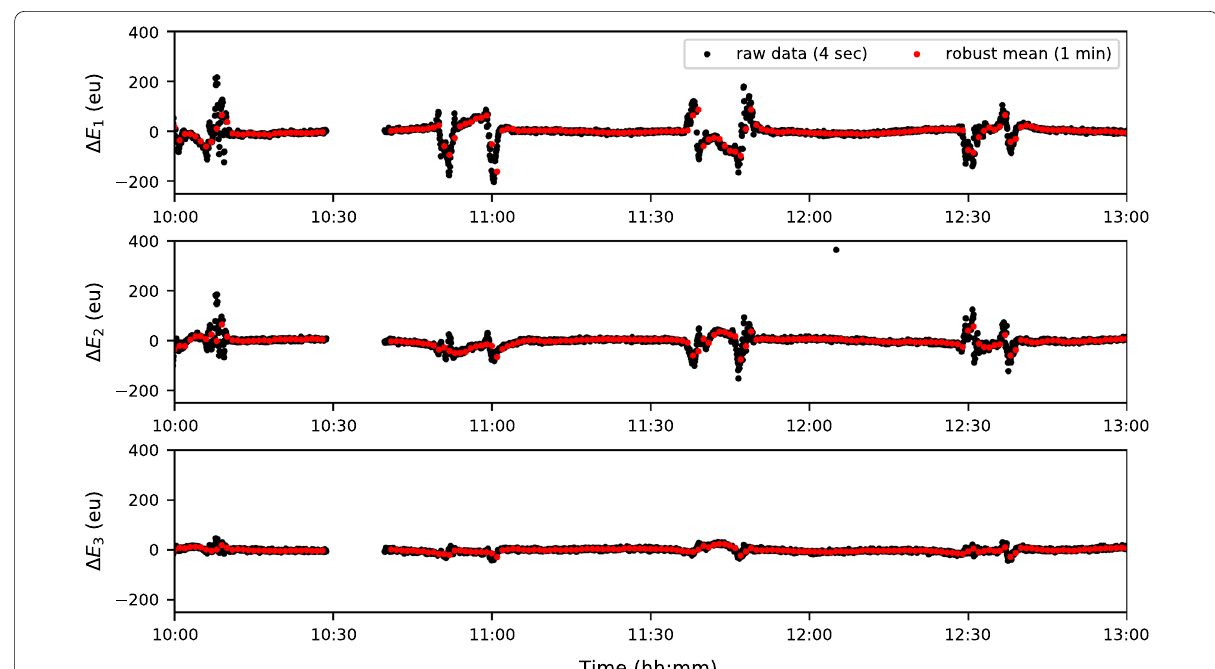
Fig. 1 Residuals of raw vector data from CryoSat-2 FGM1 with respect to the CHAOS-6-x9 model values in the uncalibrated magnetometer frame for an example period of 3 h on March 24, 2016. The gap in the raw data between 10:30 and 10:40 is due to the rejection of data with poor attitude information ( q error > 40 ′′